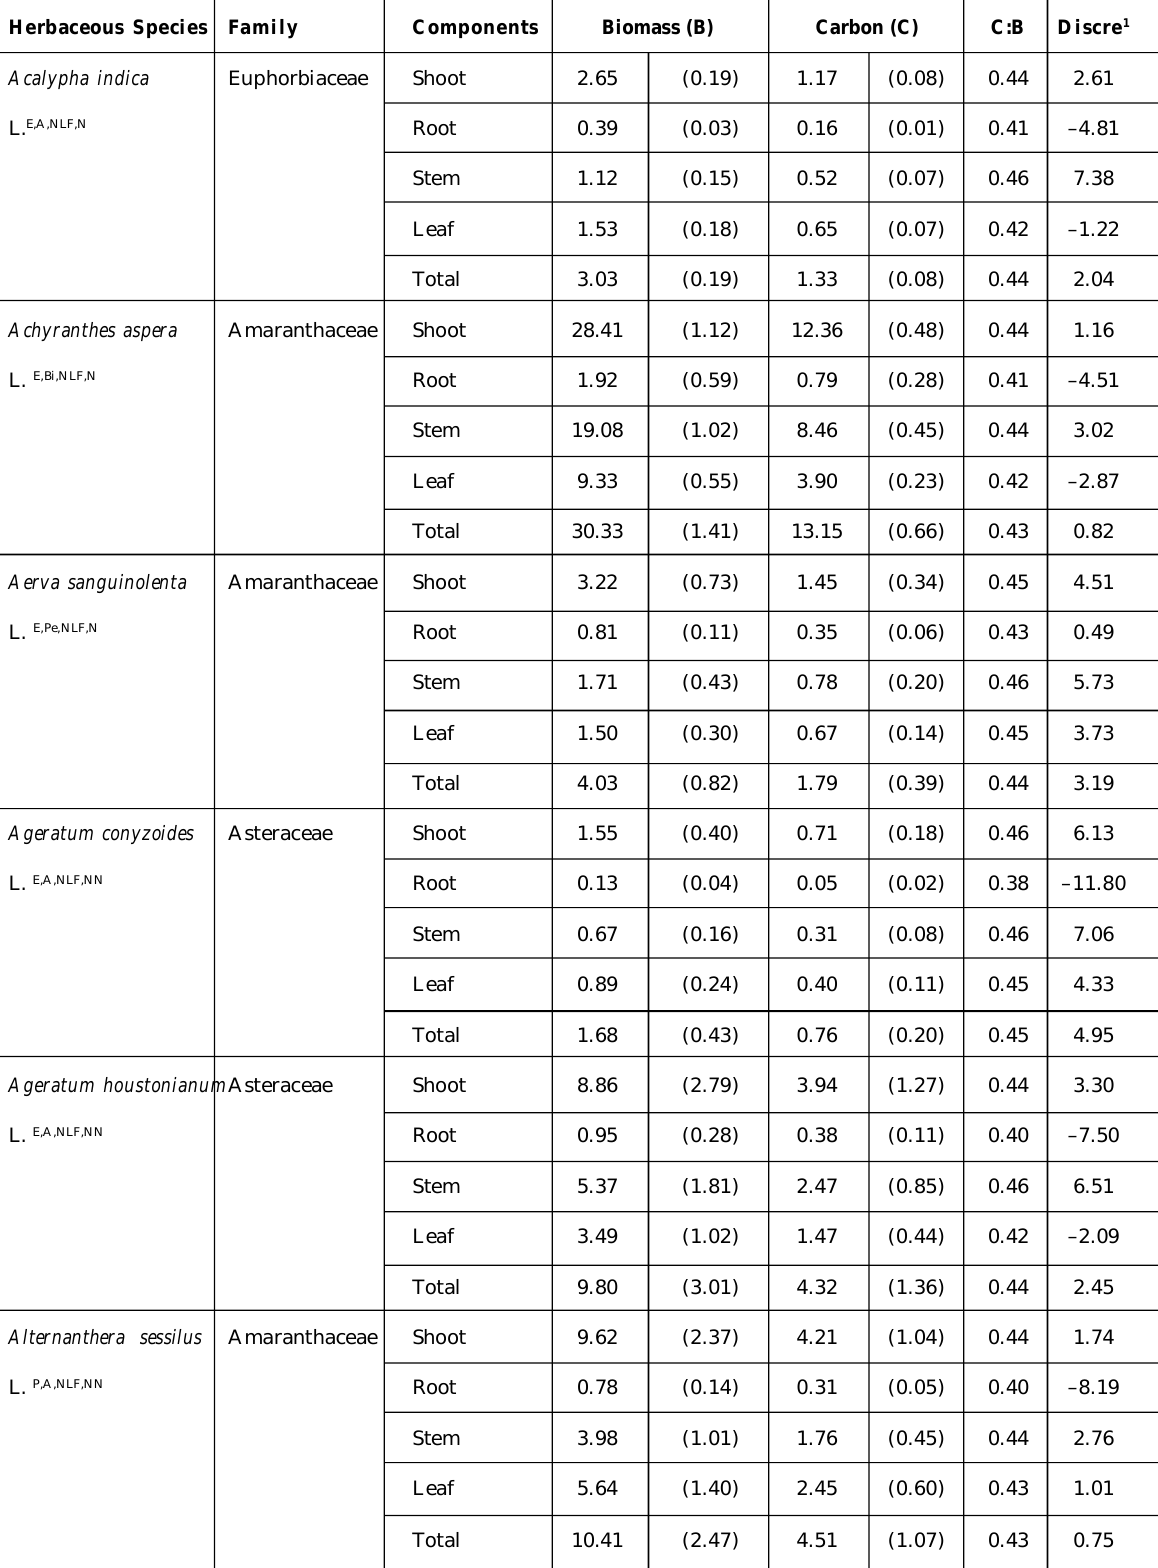
Table A1: Species-wise variation in mean dry biomass (g plant -1 ), carbon content (g plant -1 ), carbon to biomass ratio (C: B) and percent discrepancy in prediction based on average C: B (Discre 1 = 0.43) herbaceous species occurred in tropical grassland at Varanasi, India. Values in parentheses are ± 1 SE. The abbreviations used; AGB = above ground dry biomass, RB = root biomass, E = Erect, P = Prostrate, De = Decumbent, Pro = Procumbent, A = Annual, Bi = Biennial, Pe = Perennial, G = Grasses, Se = sedge, NLF = Non leguminous forbs, LF = leguminous forbs, N = Native, NN = Nonnative, COS =